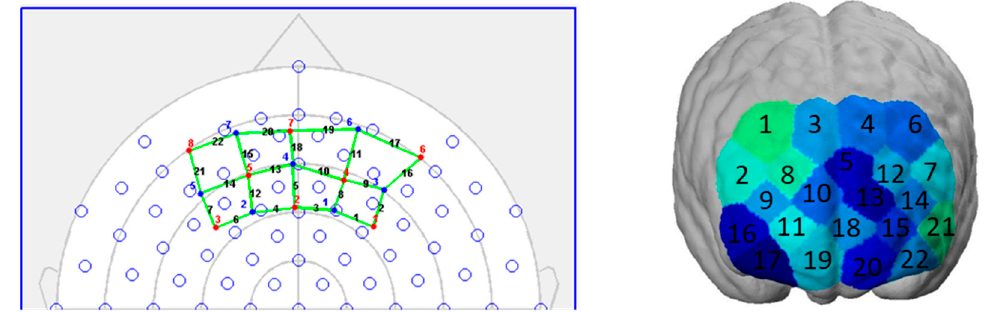
Figure 3. (Left) Topographical layout of the NIRx headband. The red numbers (1–8) point out the placement of the light sources, and the blue numbers (1–7) the placement of the light detectors. One source and one detector result in one measurement channel, visualized through the black channel numbers (1–22). The reference points refer to the EEG 10–20 system. (Right) The coverage of the headband is shown on the ICBM 152 head model. The color shadings do not have any meaning here.